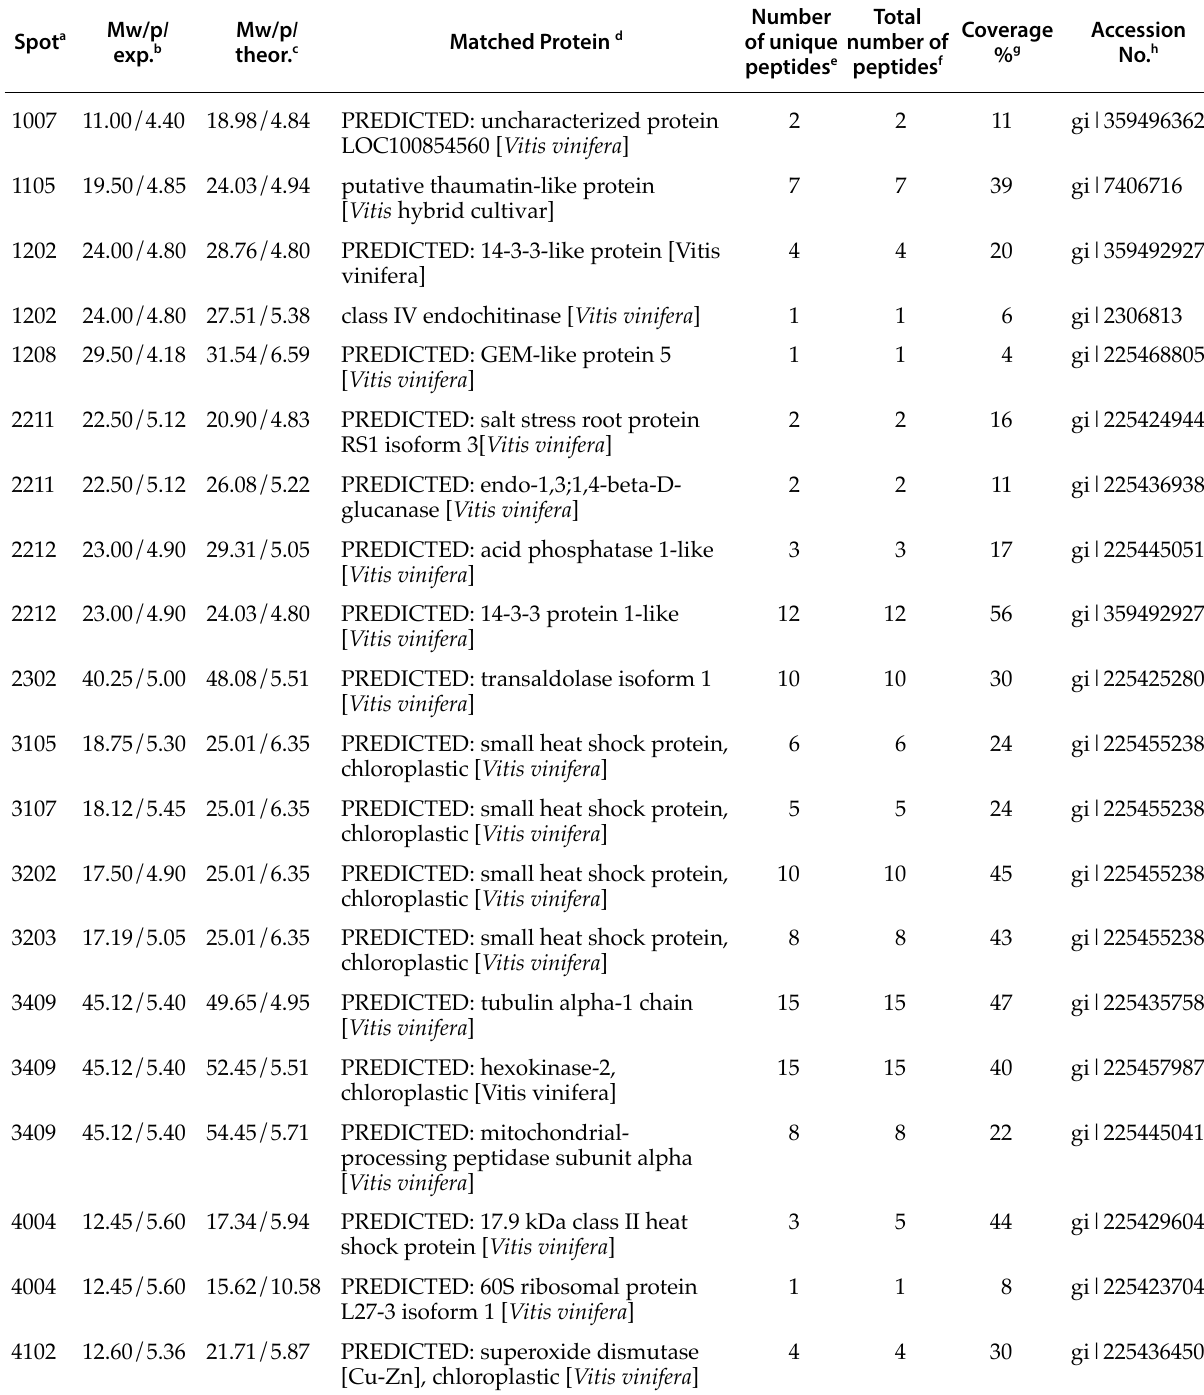
Table 1. Identified proteins differentially expressed in the black streaked or asymptomatic trunk wood of control, apoplec - tic and esca proper affected